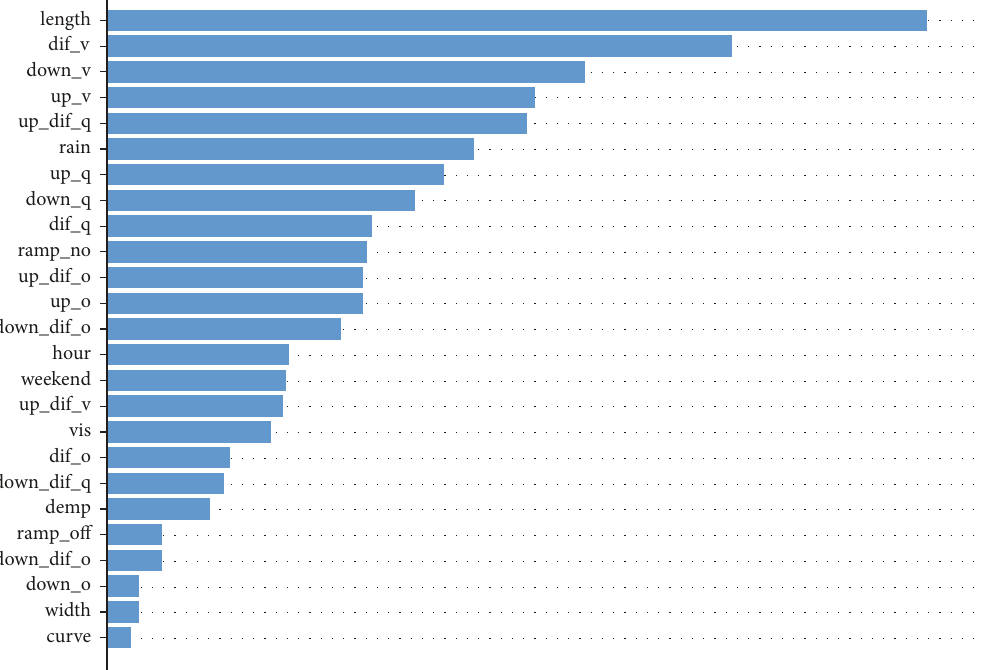
Figure 5: Ranking chart of variables’